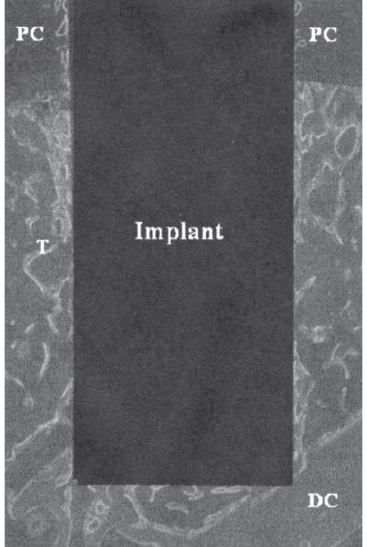
FIGURE 2- Merged micrographs (20x original magnification) revealing perimeter and bone structure around a 4-week titanium alloy (control) implant. Note the presence of tetracycline labels in both cortical and trabecular bone in proximity and away from the implant surface. PC- tibiae proximal cortical plate, DC- tibia distal cortical plate, T-